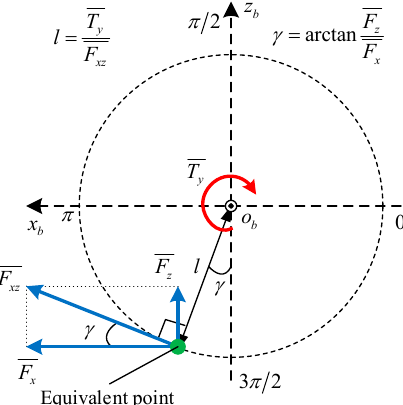
Figure 11. The definition of the equivalent point.